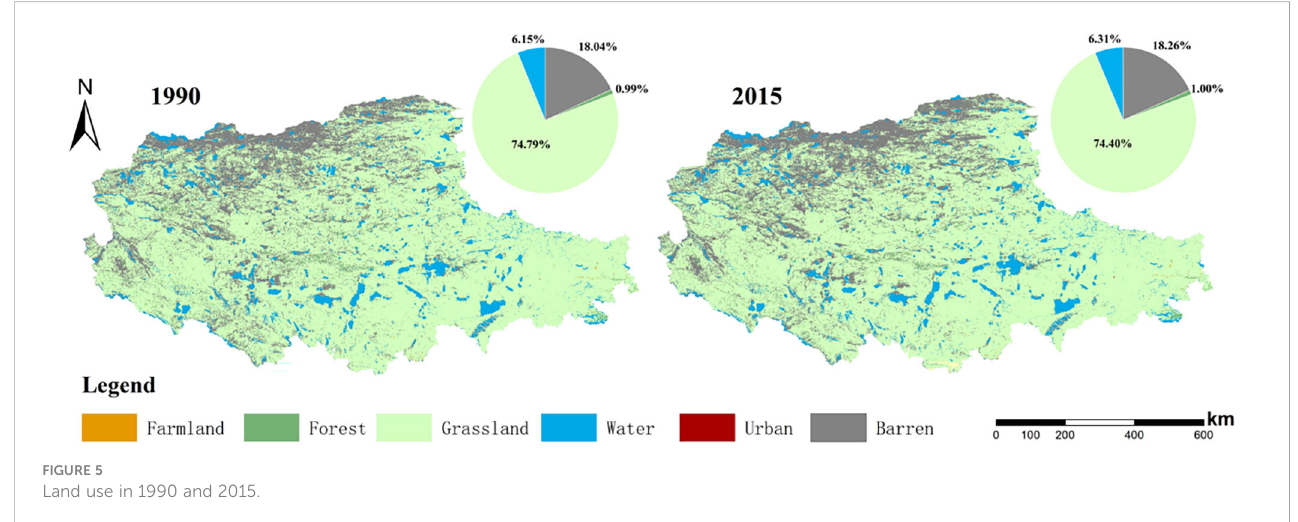
FIGURE 5 Land use in 1990 and